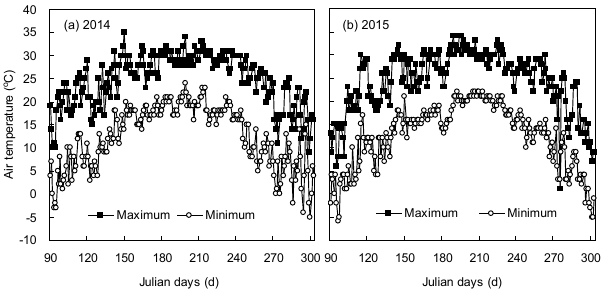
Figure 1. Daily maximum and minimum air temperatures in 2014 and 2015 in Shengyang, Liaoning, Fig. 1